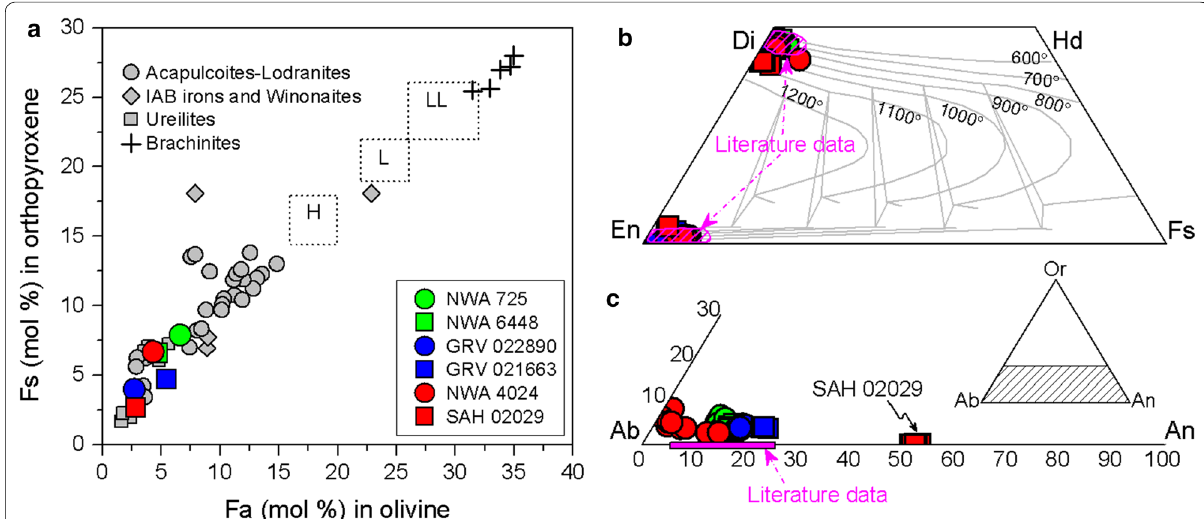
Fig. 5 Mineral composition of silicate phases in winonaites. a Fa versus Fs (mol %) in olivine and orthopyroxene, respectively (modified from Folco et al. 2006); composition of pyroxene ( b ) and plagioclase ( c ) in the studied meteorites (the literature data were taken from Goodrich et al. 2011). The two-pyroxene thermometer boundaries were taken from Lindsley and Andersen